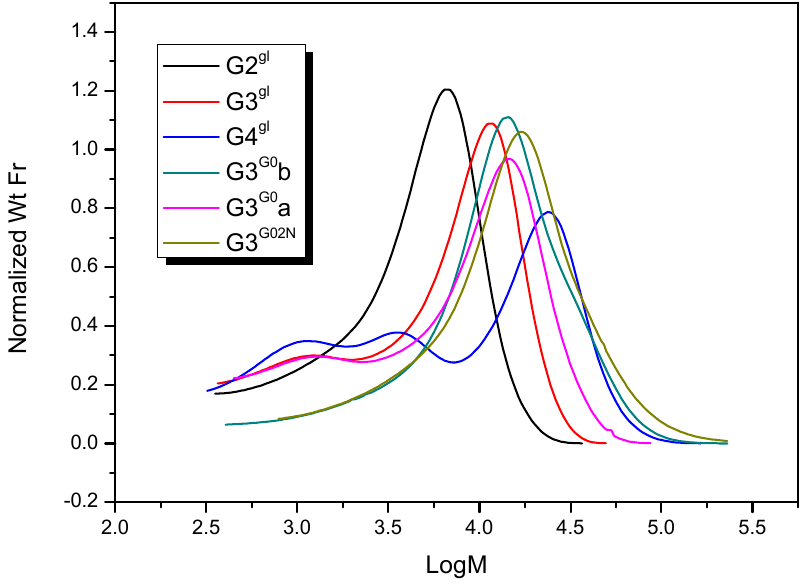
Figure A2. Molecular weight distribution curves of megamers G3 G0 and G3 G02N estimated using GPC experiments using the references obtained by reaction of PAMAM dendrimers G2, G3, and G4 with gl according to the protocol described for G3 gl . Obtained derivatives bear 46, 78, and 140 2,3- dihydroxyproyl substituents and averaged molecular weight 6600, 12,681, and 24,575 Da, respectively for G2 46gl , G3 78gl , and G4 140gl . The stoichiometry of these G2 gl , G3 gl , and G4 gl derivatives was determined using 1 H NMR spectroscopy. The G2 gl , G3 gl , and G4 gl were used as molecular weight standards to determine the molecular weight of megamers. The figure represents normalized weight fraction vs logM (where M—molecular weight). Samples of megamers G3 G0 a and G3 G0 b were obtained from G3 64gl : 18 NPCF : 20 G0 according to general protocol described in Experimental section. The average molecular weight of the samples G3 G0 b and G3 G0 a were estimated for conjugate before (b) and after (a) dialysis. Partial loss of G0 from the conjugate upon three days extensive dialysis can be concluded from that experiment (from average 13 to 10). Table A2. Molecular weight parameters determined using GPC (see Figure A2 for description).